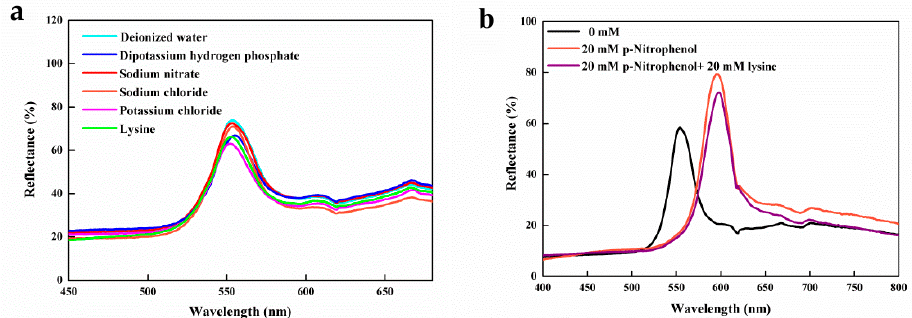
Figure 6. ( a ) Optical response of the IOPPCs in common compound solutions; ( b ) optical response of the IOPPCs in interferents and PNP mixed solution.